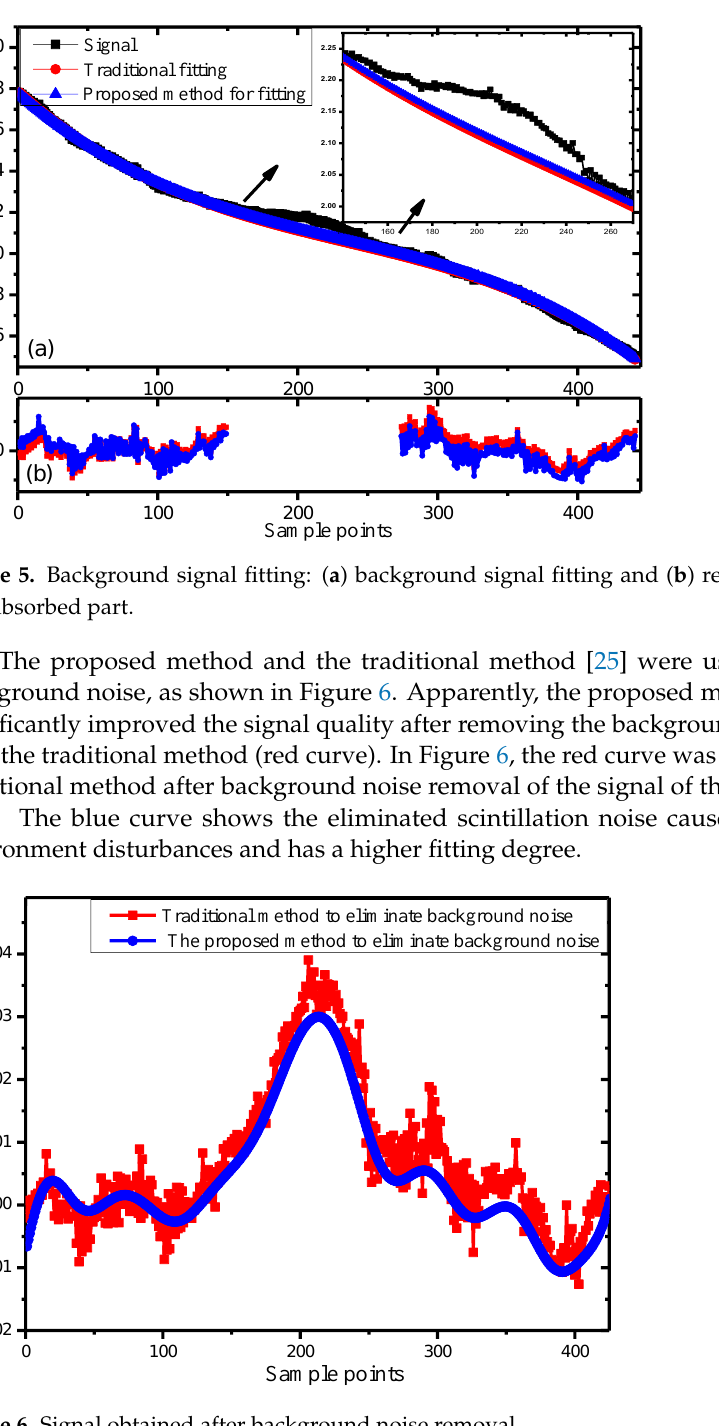
Figure 4. Extraction and reconstruction of the main feature information. ( a ) Signals before and after the extraction and reconstruction of the main feature information; ( b ) Residual.